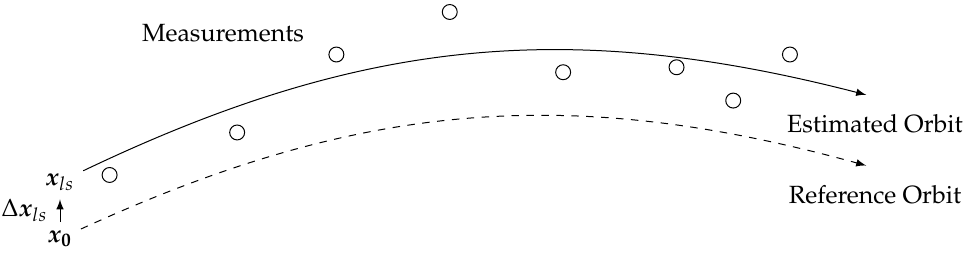
Figure 5. Illustration of the orbit determination process, starting with a reference orbit and then estimating an orbit adjustment to best fit the